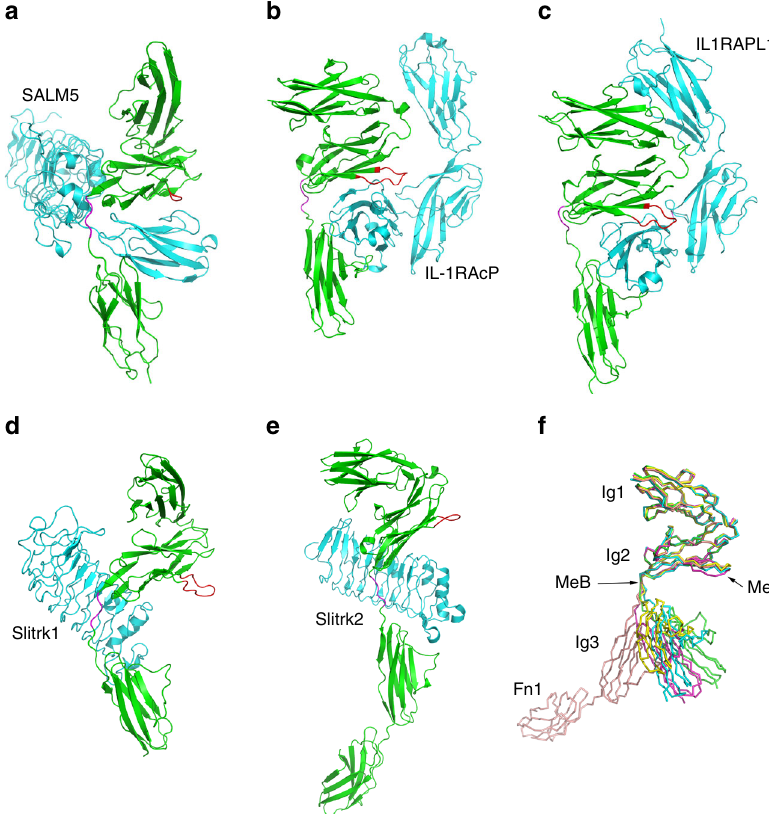
Fig. 6 Comparison of PTP δ in complexes with different ligands. a – e Ribbon representations of PTP δ in complexes with SALM5 (this paper; PDB code, 5XNP), IL-1RAcP (4YFD), IL1RAPL1 (4YH7, Fn domains not shown), Slitrk1 (4RCA), and Slitrk2 (4Y61). PTP δ and PTP σ are colored in green with MeA splice insert in red and MeB in pink. f Superimposition of PTP δ bound with different ligands: SALM5 (green), IL1RAPL1 (cyan), IL-1RAcP (yellow), Slitrk1 (pink), and Slitrk2 (salmon). PTP δ bound with Slitrk2 has an extra domain, Fn1, represented in the